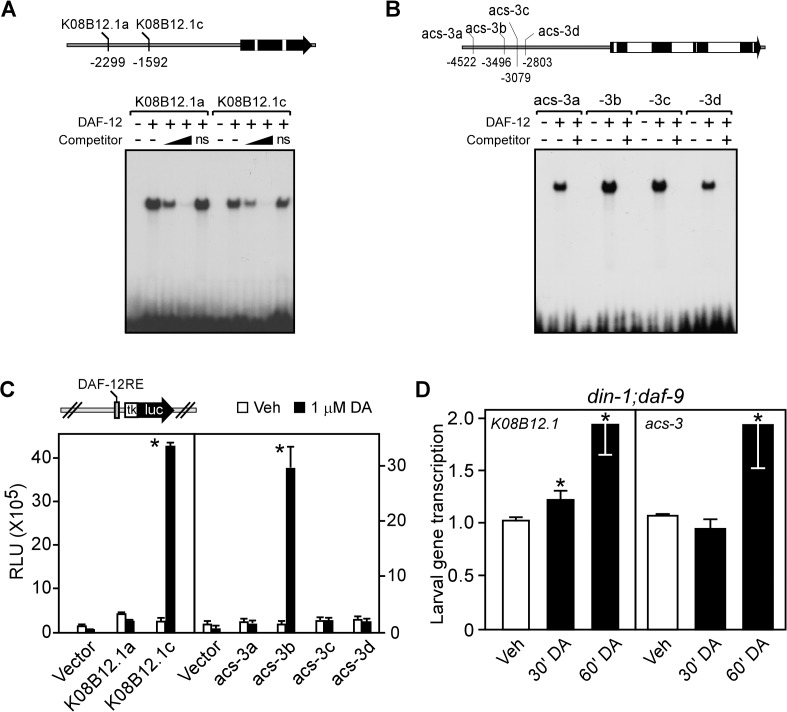
Fat utilization genes are direct targets of C. elegans DAF-12.(A, B) Gel electrophoresis mobility shift assays with [32P]-labelled oligonucleotides corresponding to each of the candidate DAF-12 response elements (shown in the schematics of the promoters above the panels) for TG lipase (K08B12.1) and acyl-CoA synthase (acs-3). Gel shifts were performed in presence or absence of in vitro translated DAF-12 protein ± the presence of 20-fold and 200-fold (in A) or 200-fold (in B) excess unlabeled competitor oligonucleotides. ns, non-specific oligo at 200-fold excess. (C) Luciferase reporter assays with candidate response elements shown in (A,B) from HEK293 cells cotransfected with reporter and DAF-12 expression plasmids and treated with vehicle or 1 μM DA (n = 3 ± S.D.). (D) Nuclear run-on assays of K08B12.1 and acs-3 transcription in L2 larvae of din-1;daf-9(dh127;dh6) worms transiently treated by vehicle or 500 nM DA (n = 3 ± S.D.). *P< 0.05 comparing vehicle to DA treatment by Student’s t-test. Vehicle, ethanol; DA, Δ7-dafachronic acid.